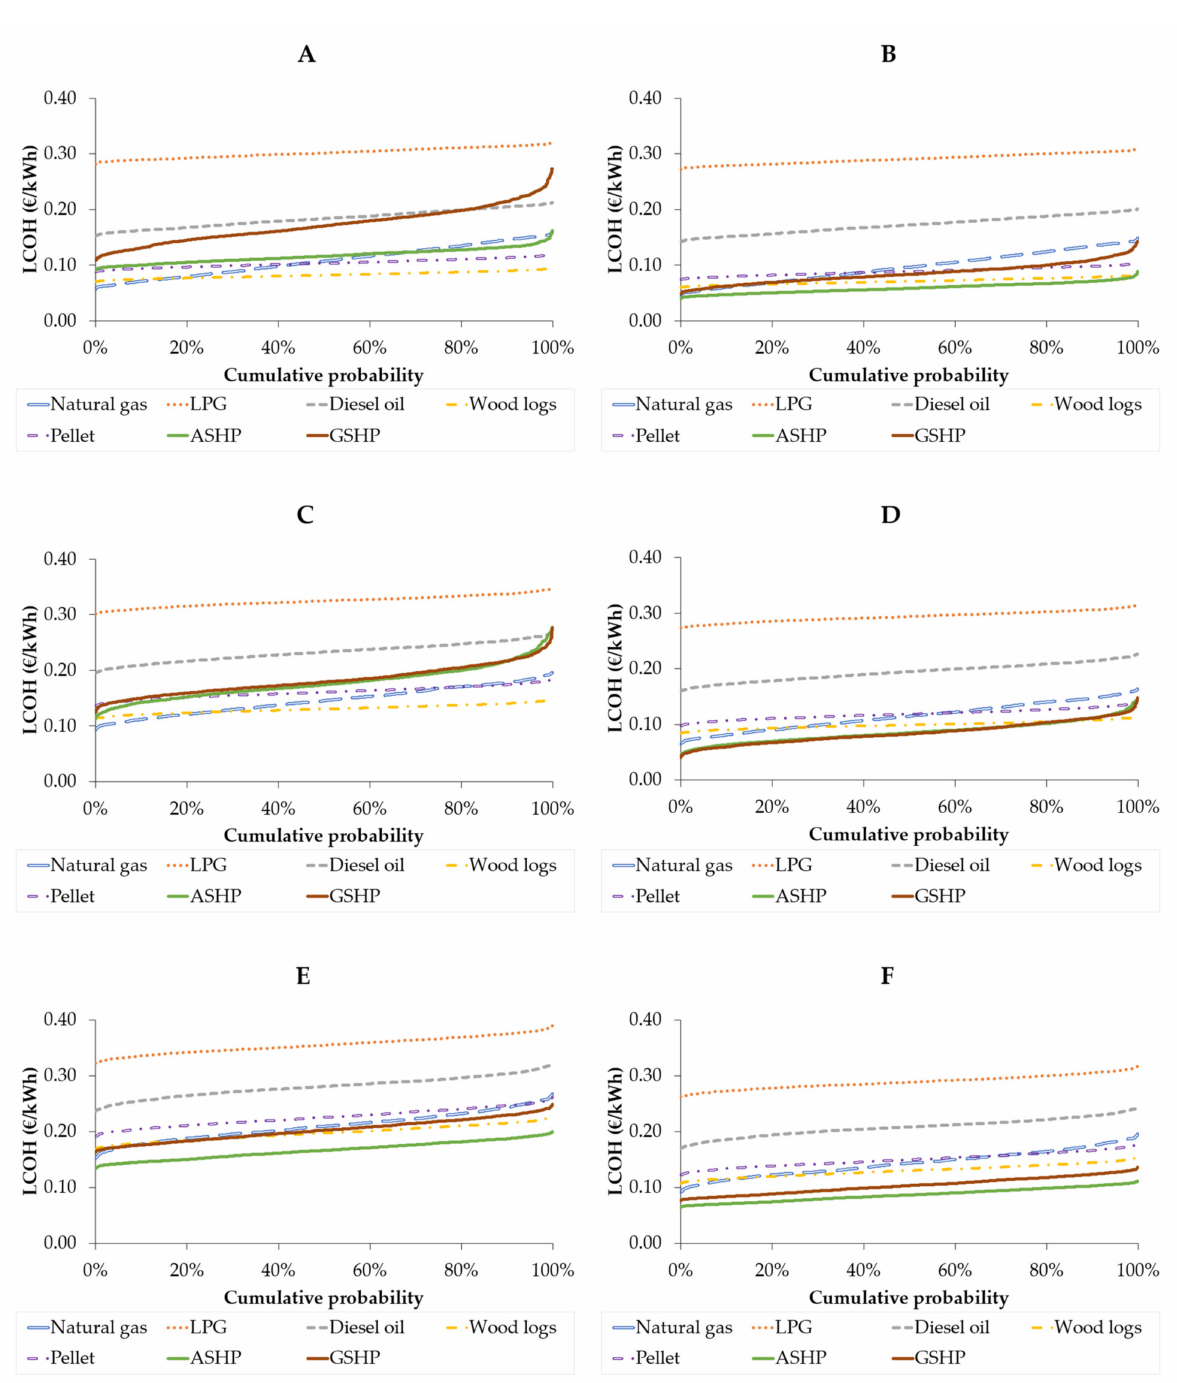
Figure 5. Probabilistic distributions of LCOH values in a detached house in Turin in the following cases: ( A ) heating-only after partial renovation without incentives; ( B ) heating-only after partial reno- vation with incentives; ( C ) heating-only after complete renovation without incentives; ( D ) heating- only after complete renovation with incentives; ( E ) heating and cooling after complete renovation without incentives; ( F ) heating and cooling after complete renovation with